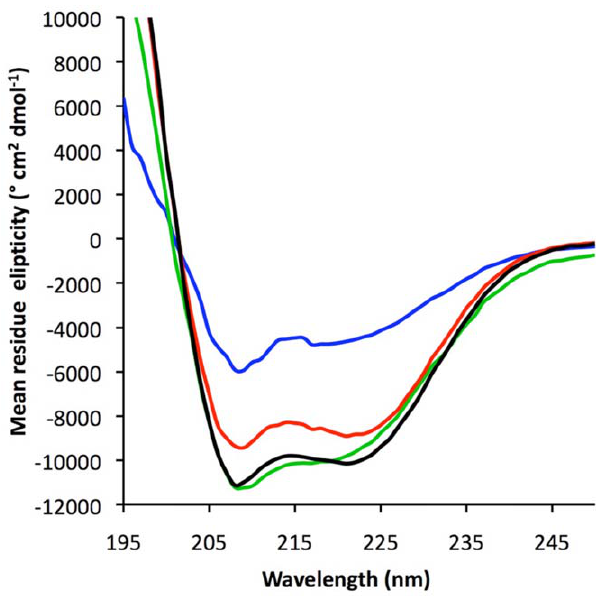
Figure 4. Nucleotide-free G a i1 is relatively unstructured in comparison to G a i1 N GDP, but regains helical secondary structure in the complex with Ric-8A. Circular dichroic spectra were normalized as mean residue elipticity, and predicted secondary structure assignments are: Ric-8A, red : 87% a -helix; Ric-8A:G a i1[ ], black : 87% a -helix, 0.5% b -strand; G a i1 N GDP, green : 51% a -helix, and 11%